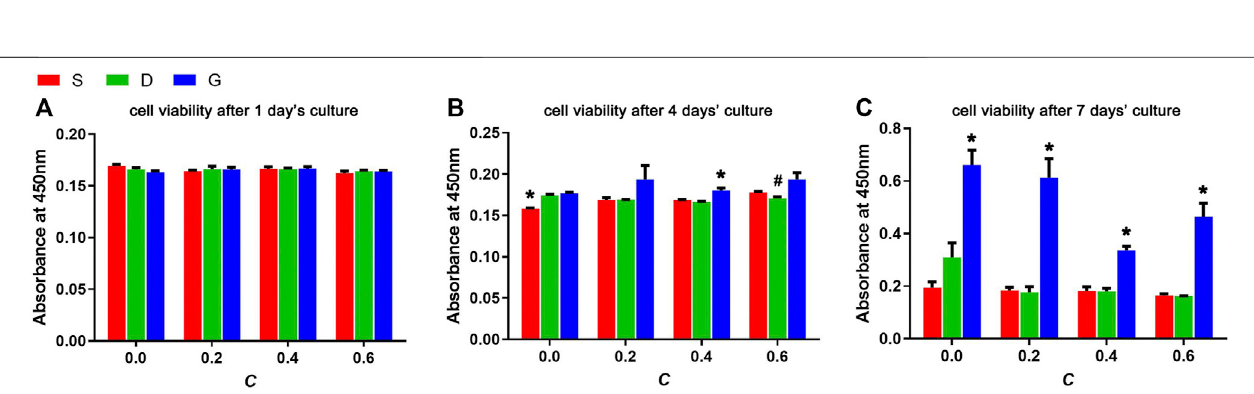
FIGURE 9 | Cell viabilities of rMSCs after (A) 1 day ’ s culture, (B) 4 days ’ culture and (C) 7 days ’ culture on scaffolds with varied TPMS architectures (n = 3, *indicates signi fi cant differences compared with the other two groups, #indicates signi fi cant differences compared with the G group, p <